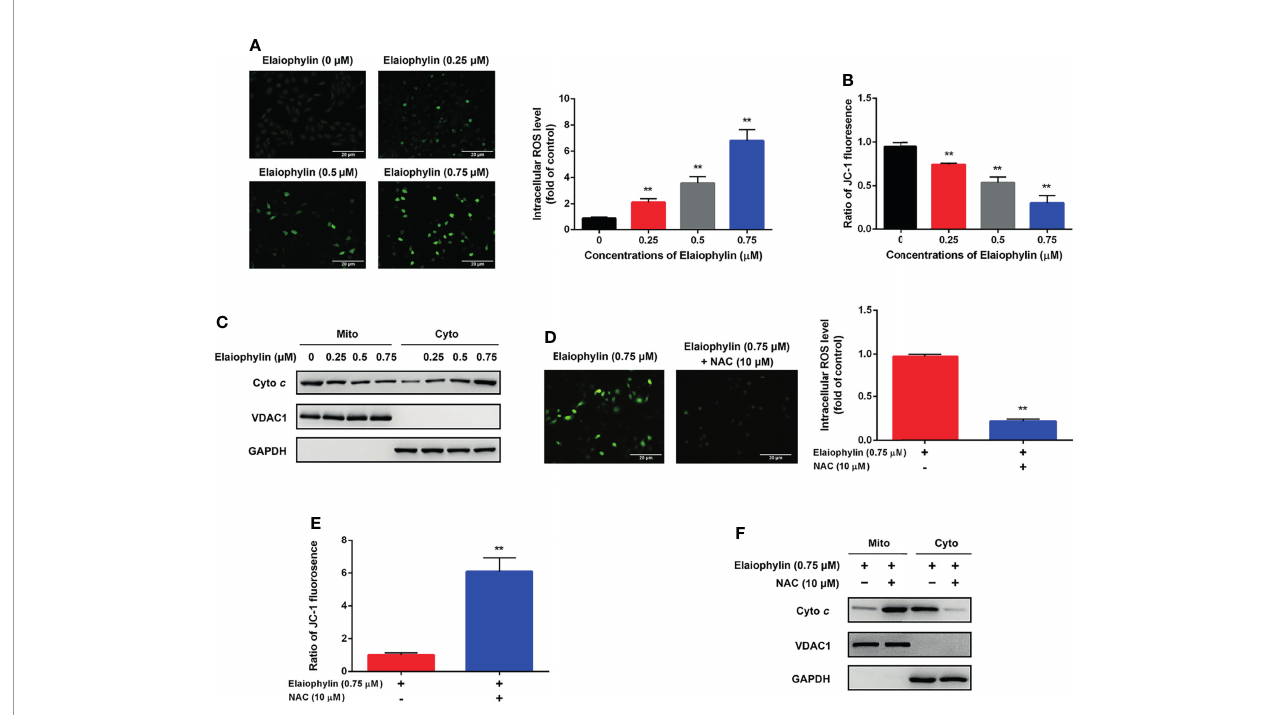
FIGURE 2 | Elaiophylin induces oxidative stress and mitochondrial dysfunction in C918 cells. C918 cells were exposed to indicated concentrations of Elaiophylin, with or without NAC (10 m M) pre-treatment. (A, D) The representative images of ROS measurement (green fl uorescence) in C918 cells after 2 h exposure to Elaiophylin. Intracellular ROS levels were detected by DCFH-DA fl uorescent probe. The representative images of fl uorescent probe were shown on the left and the quantitative analysis of ROS level was shown on the right. (B, E) The MMP of C918 cells exposed to indicated concentrations of Elaiophylin, with or without NAC. (C, F) Lysates of C918 cells exposed to indicated concentrations of Elaiophylin, with or without NAC were separated into cytoplasmic and mitochondrial fractions. Cytochrome c translocation was measured by western blotting. GAPDH and VDAC1 were used as loading controls for cytoplasm and mitochondria, respectively. Data was expressed as mean ± SD of three experiments. ** p <0.01 vs.